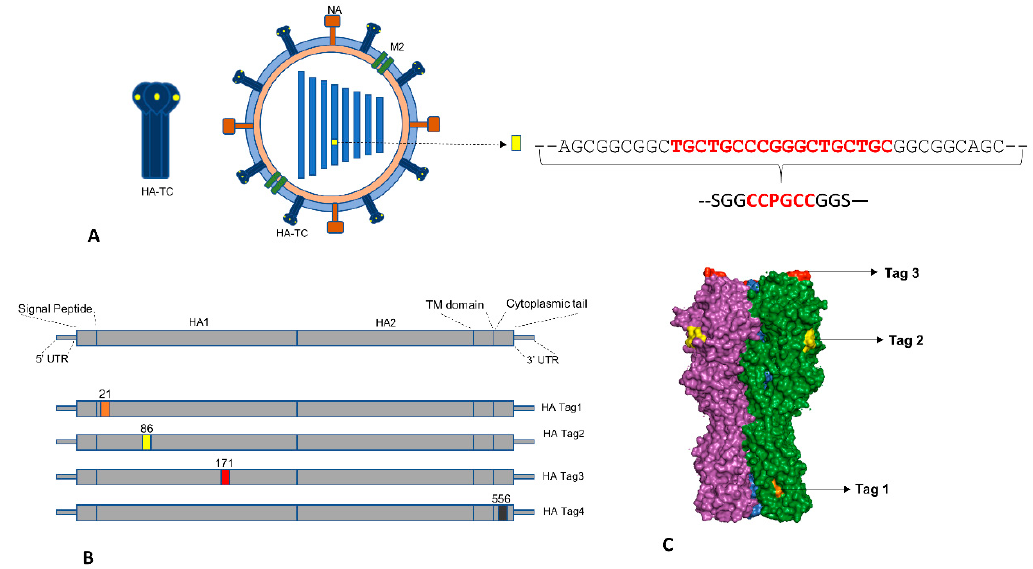
Figure 1. Scheme for generation of reporter influenza A virus (IAV) with Tetra-Cysteine tag inserted in hemagglutinin (HA): ( A ) Shows HA-TC reporter virus outline and nucleotide sequence inserted into genomic segment 4 which encodes for HA. The Red font indicates the Tetracysteine Tag and Black font indicates the linker sequences. ( B ) Shows sequence features of IAV HA and amino acid positions where TC tag was inserted in different HA-TC constructs. ( C ) Shows PyMOL generated 3D render of HA trimer (Magenta, Green and Blue monomers) showing sites for TC tag insertion (Tag 1: Orange; Tag 2: yellow; Tag 3: Red) in HA-Tag2 construct.